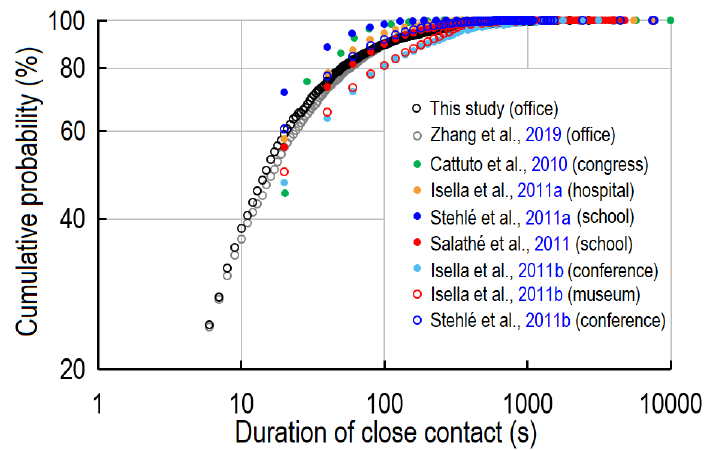
Figure 10. Cumulative probability distribution (CDF) of duration per close contact.